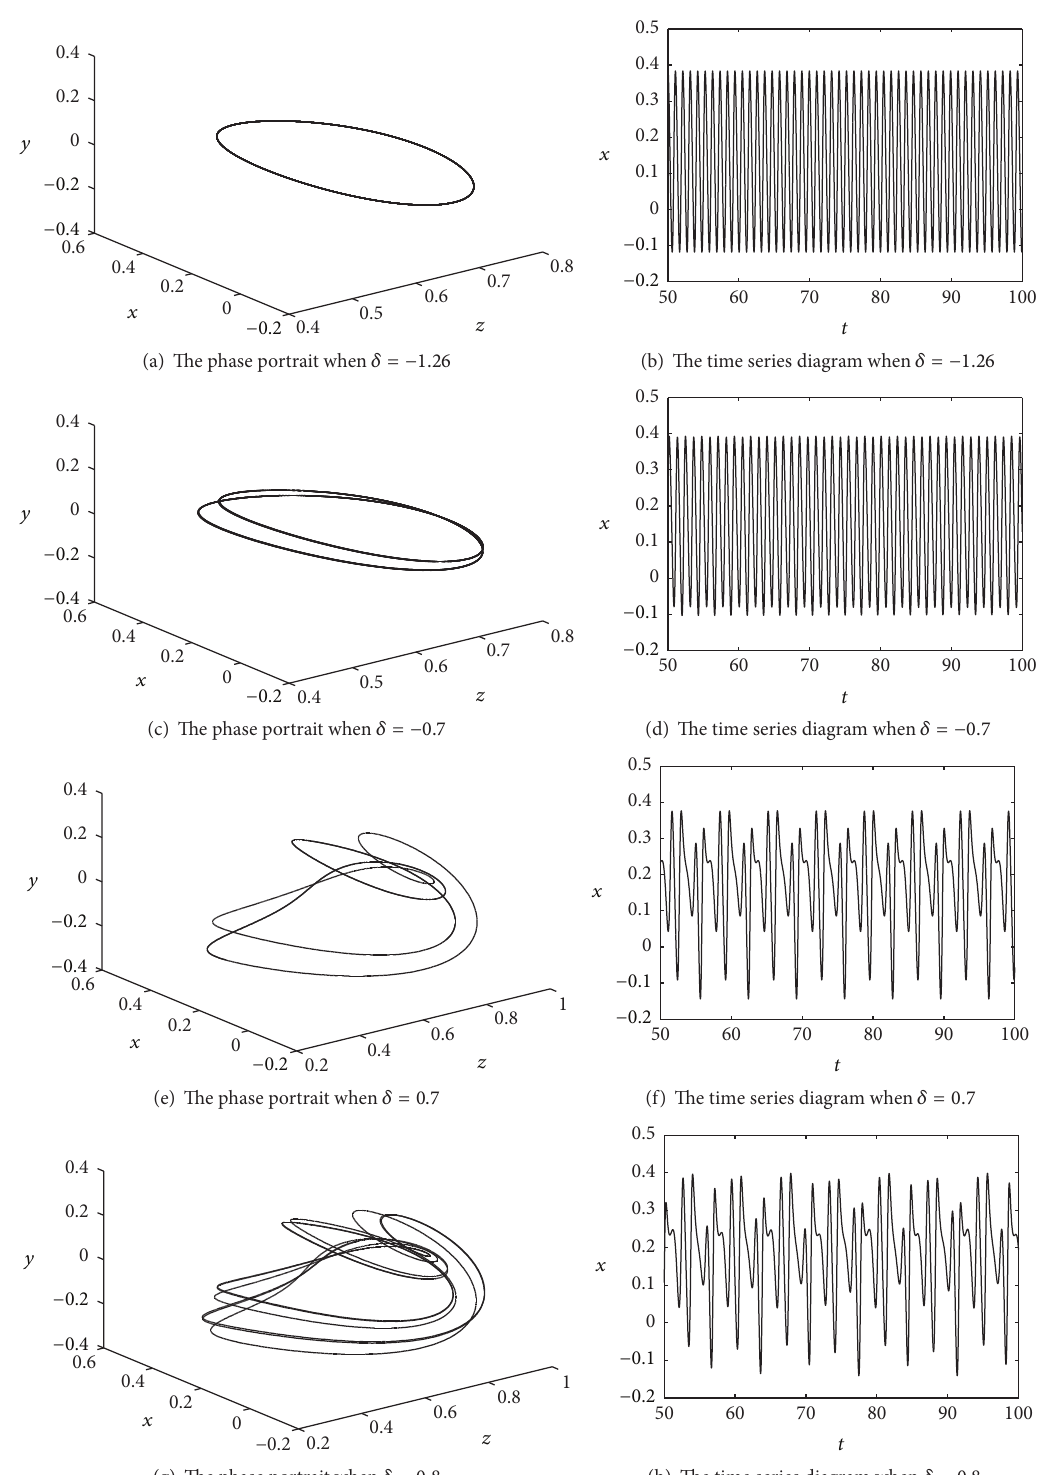
Figure 6: The phase portraits and time series diagrams of system (2) with different values of the parameter 𝛿